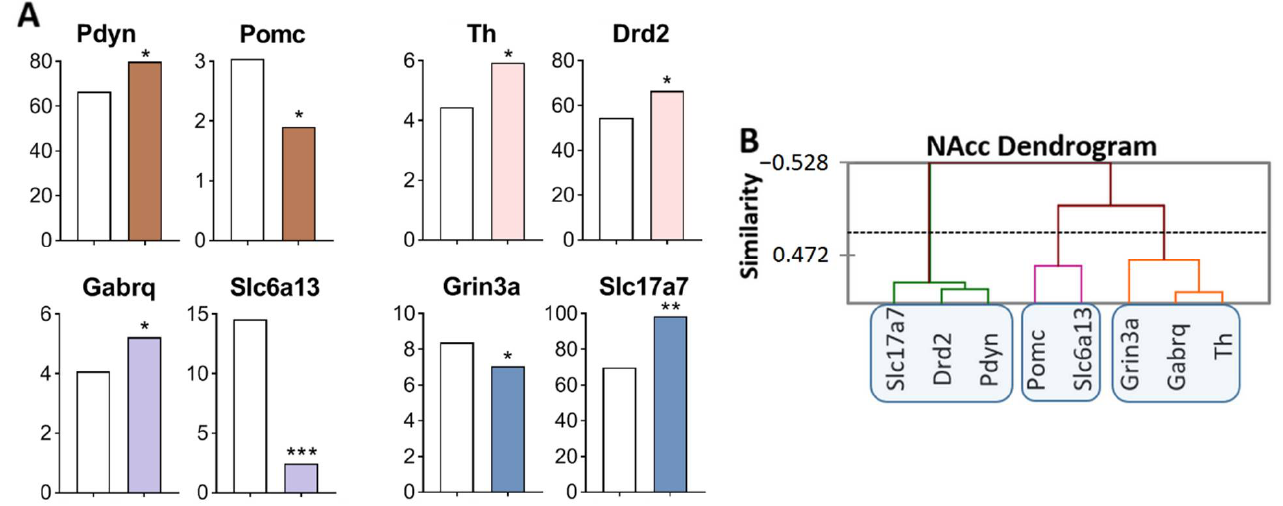
Figure 2. DEGs in the NAcc of highly aggressive mice. ( A ) FPKM of the DEGs in the NAcc (Supplementary Table S1). White bars: controls; colored bars—winners: brown—opioidergic genes; pink - CAergic genes; lilac—GABAergic genes; violet—glutamatergic genes. * p < 0.05; ** p < 0.01; *** p < 0.001. ( B ) AHC based on expression profiles of eight reference DEGs (additional information: Supplementary Table S2). Similarity: Pearson’s correlation coefficient. Agglomeration method: Unweighted pair-group average. The main clusters are highlighted with a blue rounded rectangle. Three gene clusters were identified showing a relationship among DEGs (Figure